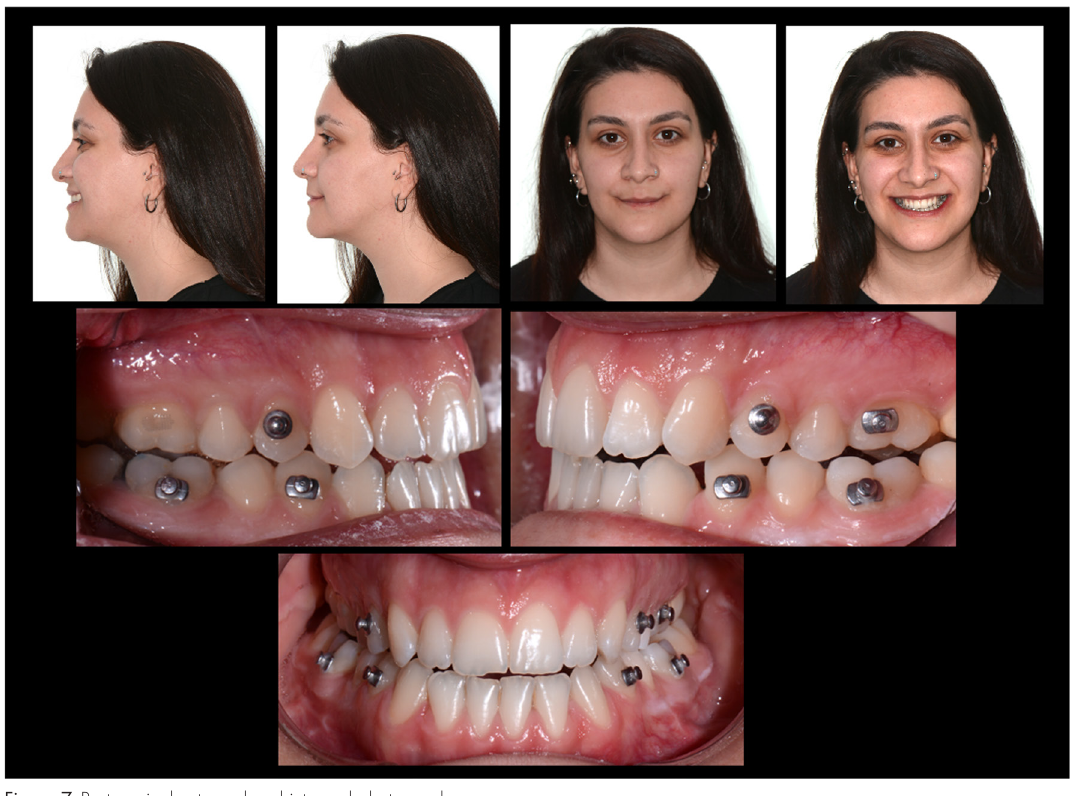
Figure 7. Post-surgical extraoral and intraoral photographs.